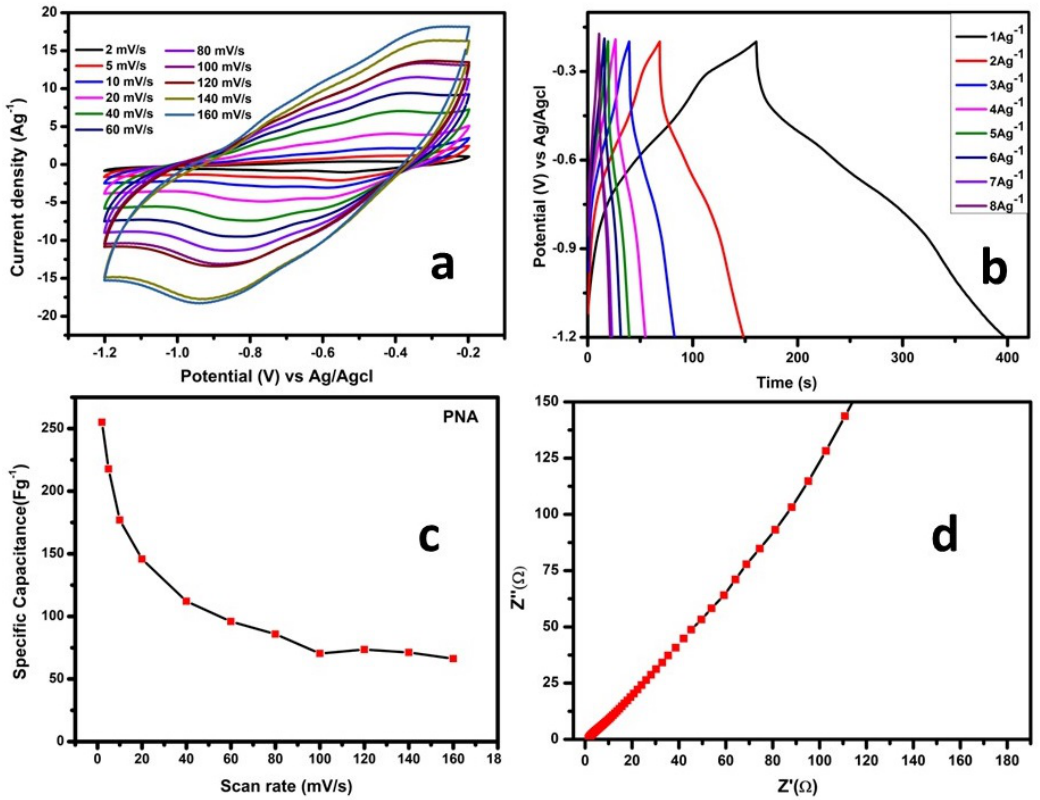
Figure 5. ( a ) Cyclic voltammetry, ( b ) galvanostatic charge–discharge, ( c ) scan rate vs. specific capacitance and ( d ) electrochemical impedance spectra for PNA nanoparticles.